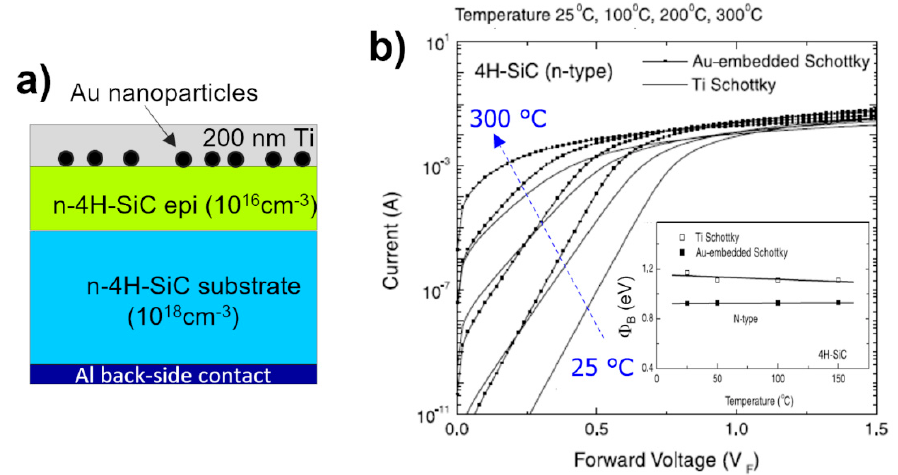
Figure 10. ( a ) Schematic view of Ti/4H-SiC Schottky contact with embedded Au nanoparticles on 4H-SiC. ( b ) Forward current–voltage characteristics of Au-nanoparticle embedded Ti/4H-SiC contact and particle-free Ti/4H-SiC control contact for different measurement temperatures (25, 100, 200 and 300 °C). Inset: comparison between the Schottky barrier height value of Au-nanoparticle-embedded Ti/4H-SiC contact and Ti/4H-SiC control contact, as a function of the measurement temperature. Figures adapted with permission from Ref. [80]. Copyright 2021 Elsevier